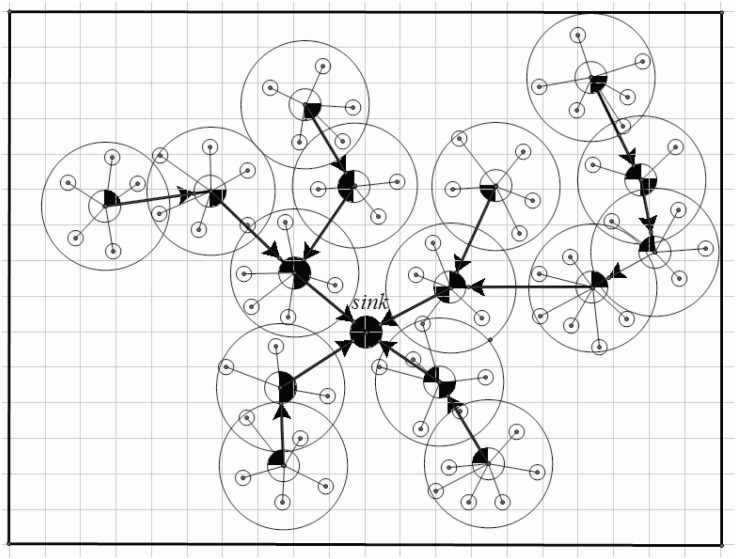
Sink in the center.